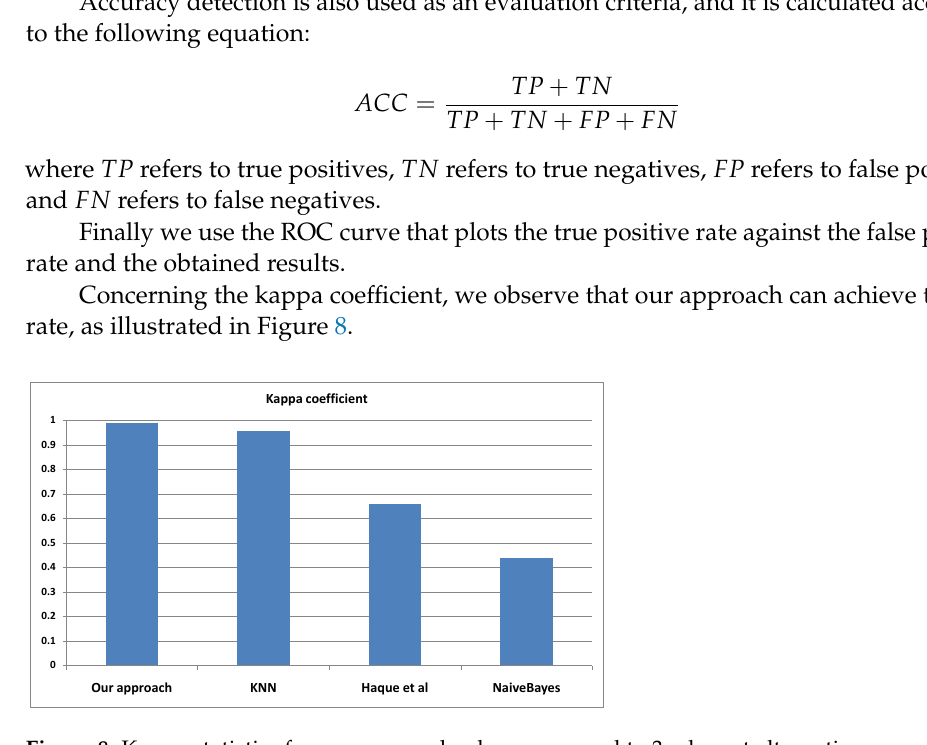
Figure 8. Kappa statistics for our approach when compared to 3 relevant alternative approaches in the literature.